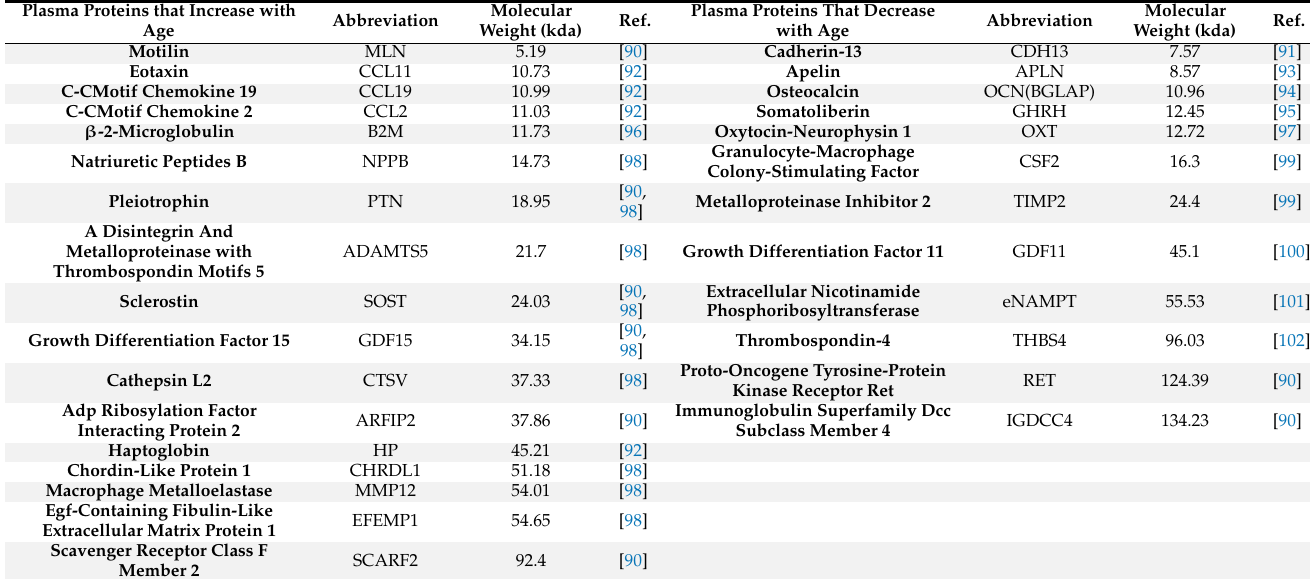
Table 2. The molecular weight of plasma proteins that are affected with